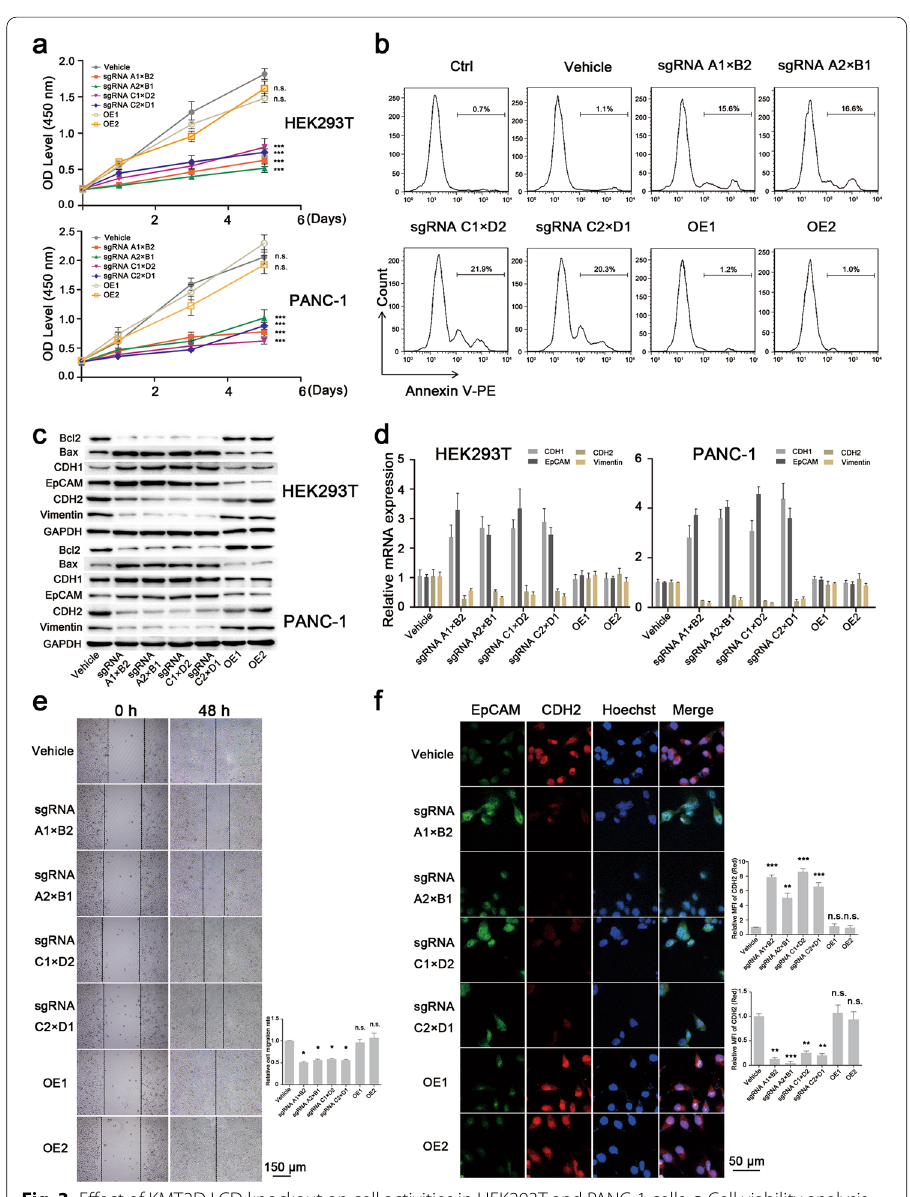
Fig. 3 Effect of KMT2D LCD knockout on cell activities in HEK293T and PANC-1 cells. a Cell viability analysis of HEK293T and PANC-1 cells carrying vectors for the vehicle or KMT2D LCD knockout at 0, 24, 72 and 120 h post-transfection. Compared with the control group (vehicle), KMT2D LCD depletion significantly suppressed cell proliferation, while the OE1 cells (LCD1-depleted KMT2D cells re-expressing full-length KMT2D) and OE2 cells (LCD2-depleted KMT2D cells re-expressing full-length KMT2D) showed restored cell proliferation compared to the wild-type cells (error bars denote standard deviation). b Representative flow cytometry of cell apoptosis assays in PANC-1 cells. The apoptotic cell ratios were significantly increased in PANC-1 cells with KMT2D LCD deficiency. c Western blotting analyses of the apoptosis- and metastasis-related proteins after KMT2D LCD knockdown in HEK293T and PANC-1 cells. KMT2D LCD deficiency increased the Bax/Bcl2 ratio and the epithelial marker-to-mesenchymal marker ratio. Bcl2, 26 KDa; Bax, 20 KDa; EpCAM, 40 KDa; Vimentin, 57 KDa; GAPDH, 37 KDa. d RT-PCR assays of metastasis-associated markers. The gene expressions of epithelial markers (CDH1 and EpCAM) had markedly increased, while those of mesenchymal markers (CDH2 and vimentin) had decreased after KMT2D LCD depletion (error bars denote standard deviation). e Scratch wound-healing assays in PANC-1 cells. Knockout of KMT2D LCD significantly attenuated the cell migration ability. f Representative images of cell immunofluorescence determining the CDH2 and EpCAM expression in PANC-1 cells. After LCD knockout, CDH2 expression significantly reduced while that of EpCAM increased. All values are means SD. Data are representative of three independent ±